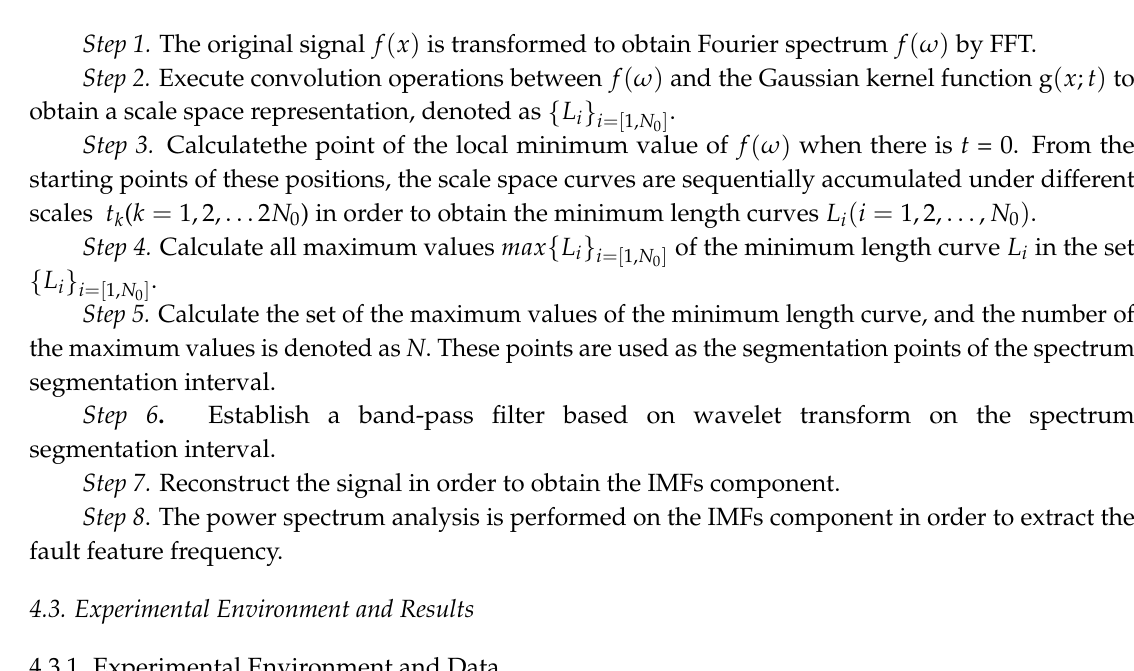
Figure 3. The flow of the MSCEWT method.